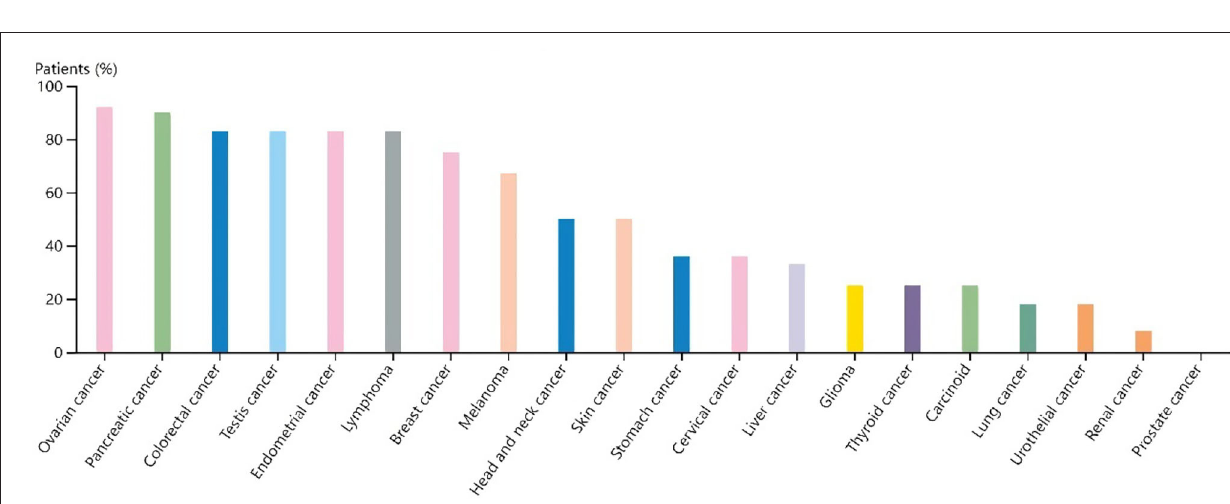
for correlation analysis ( Figure 7 ) based on the TPM of the DEGs and showed that THBS1, SERPINE1, and FGF2 were correlated. SERPINE1 were significantly differentially expressed in the